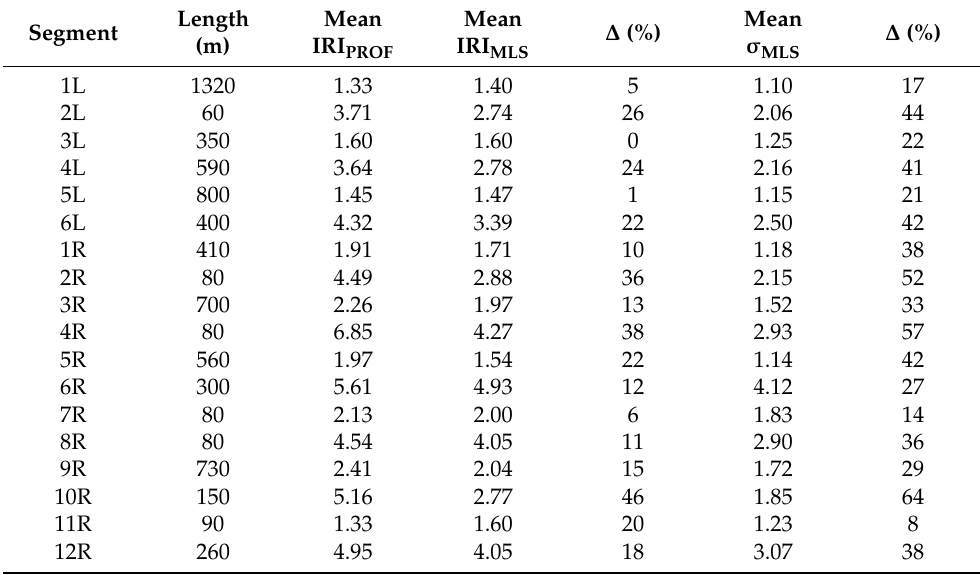
Table 6. Variation of IRI values along the 18 identified homogeneous